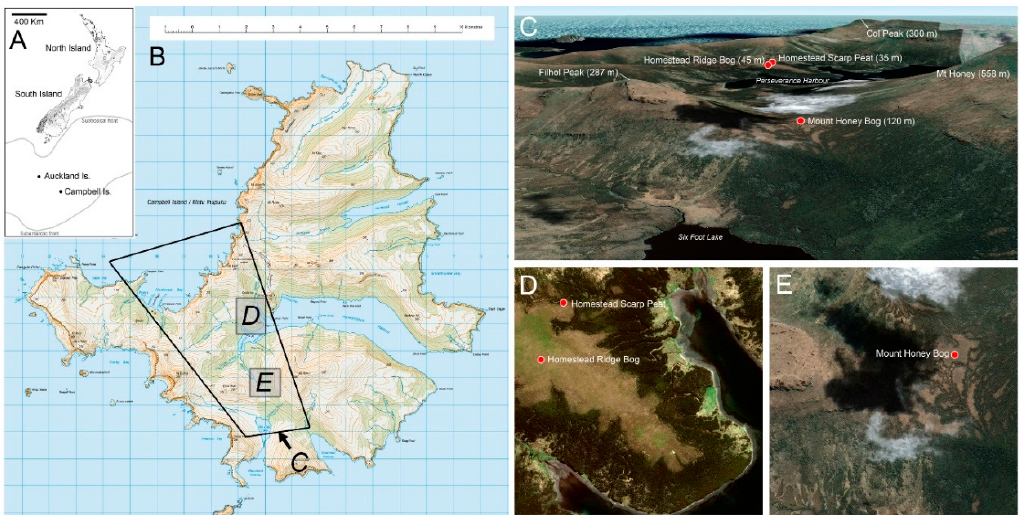
Figure 1. Campbell Island. Location in the southern part of the ocean ( A ), topographic map ( B ), oblique view, Perseverance Harbour ( C ), vertical view, Homestead Ridge bog ( D ), vertical view, and Mount Honey Saddle bog ( E ). Imagery from Google Earth.